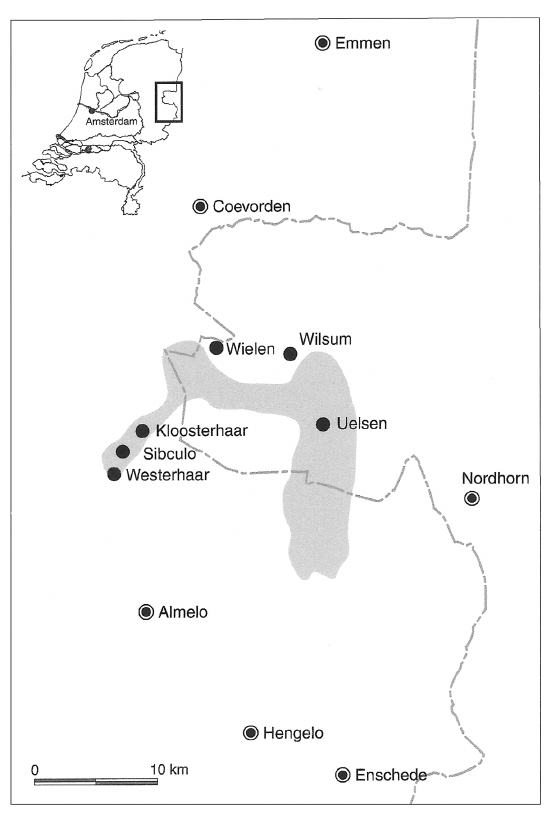
Fig. 1. Geographical map of the area from which most specimens of baksteenkalk have been collected. The highest concentrations occur in Early Pleistocene fluvio-glacial deposits which are exposed in Late Pleistocene (Saalian) ice-pushed ridges, the so-called WWW-area